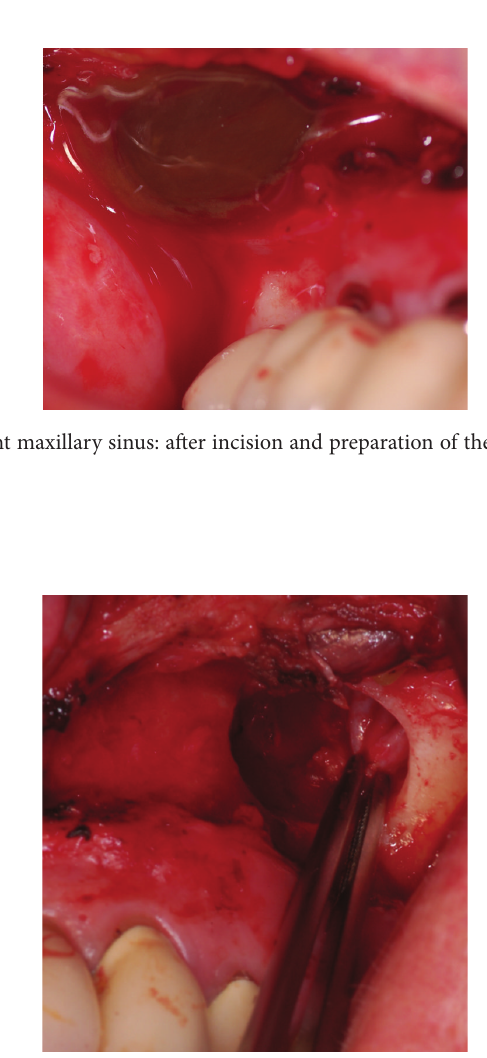
Figure 7: Intraoperative view of the left maxillary sinus: after preparation on the lift side, a bony defect is visible, smaller than on the right side. After osteoclastic preparation, the whole cystic lesion was